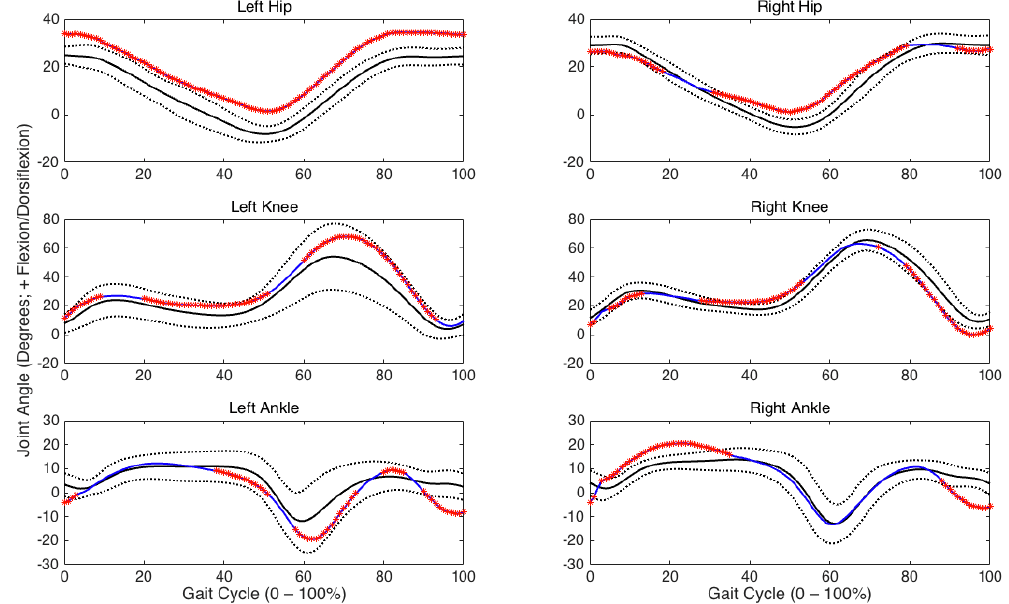
Figure 1. Differences in average hip ( top row ), knee ( middle row ), and ankle ( bottom row ) joint angles between an exemplar matched-pair of typical development (TD) and autism spectrum disorder (ASD, non-toe walker) children (Pair 10) throughout one gait cycle. Note: 0% represents ground contact; 100% represents the end of swing; Mean joint angles for the child with TD are represented by the solid black line; Mean joint angles for the child with ASD are represented by the solid blue line; The area between the grey dashed lines represents a ± 2 standard deviation band associated with the mean joint angles of the child with TD. Significant data point differences ( p < 0.05) for ASD compared to TD are denoted on the ASD curve with a red asterisk.